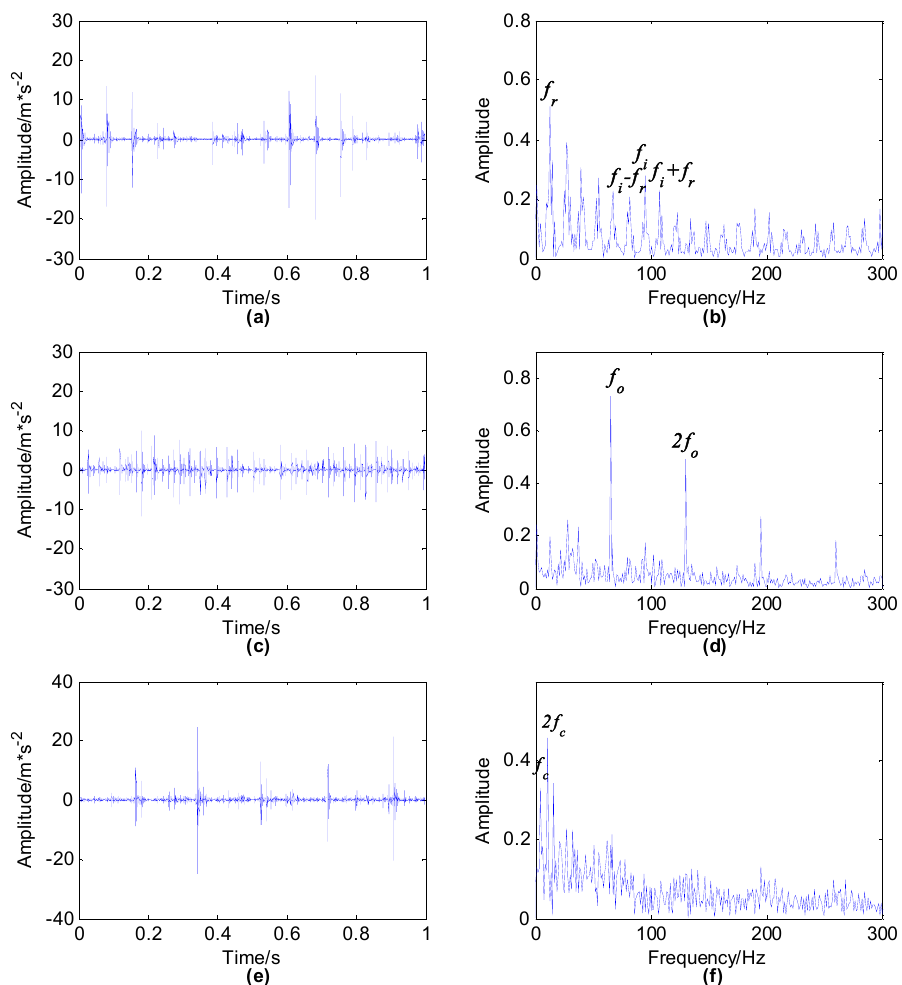
x ; ( b ) envelope spectrum of x ; ( c ) 1 1 x ; ( e ) source signal x ; ( f ) envelope spectrum of x . 2 3 3